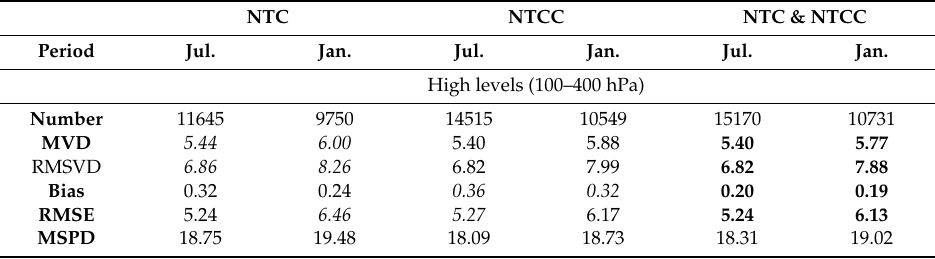
Table A6. Same as Table A5 except that rawinsonde was used as validation